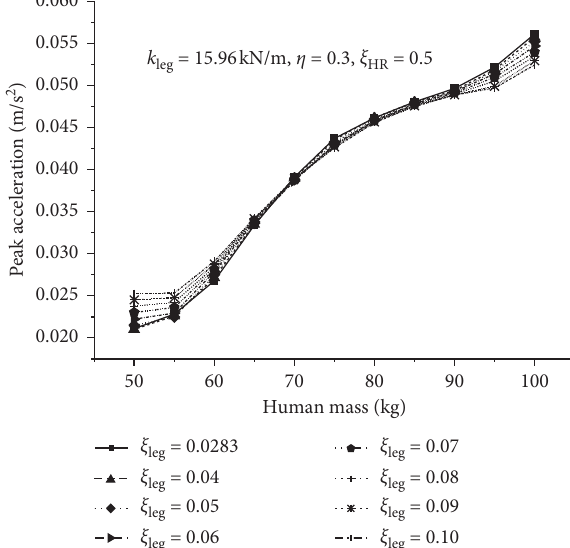
Figure 21: Peak acceleration under leg stiffness 15.96kN/m, η � 0 . 3, and ξ